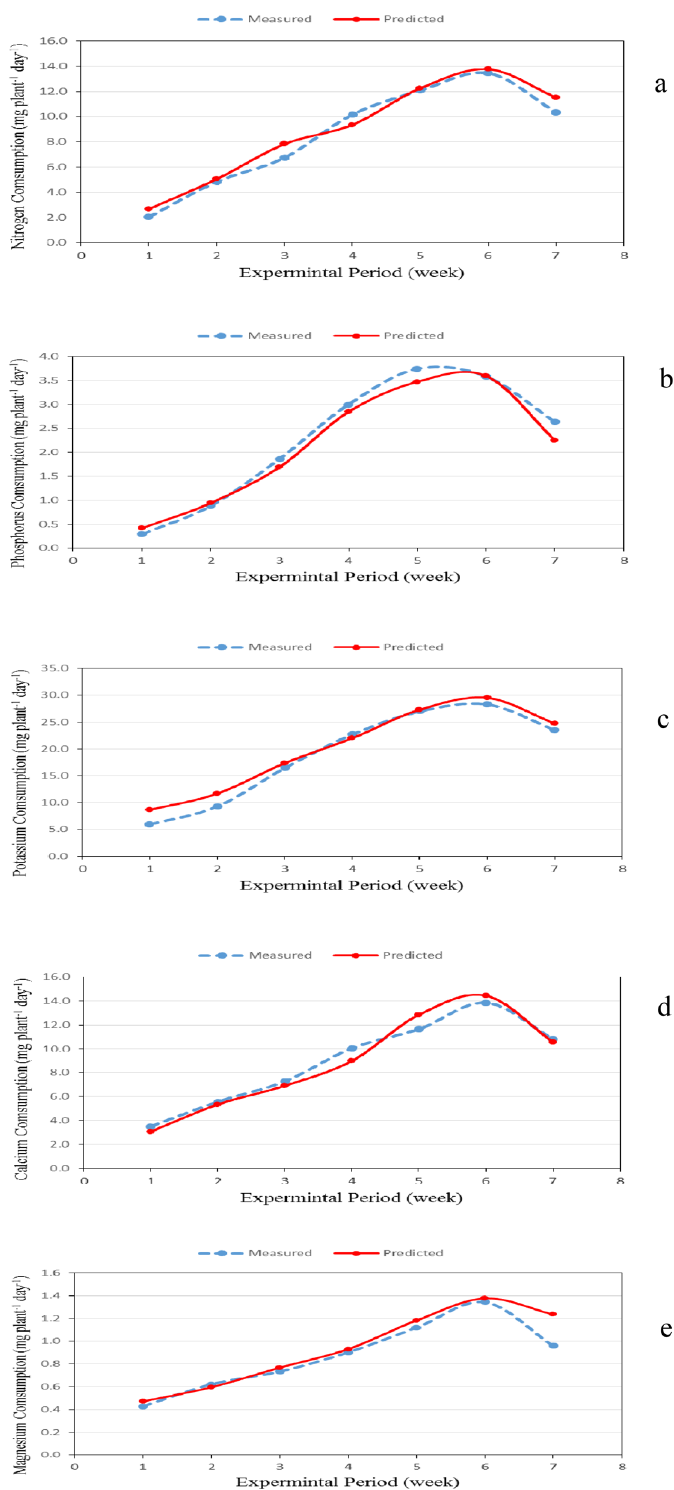
Figure 8. The predicted and the measured nutrients consumption by basil plants during the whole growth period. ( a ) N, ( b ) P, ( c ) K, ( d ) Ca, ( e )